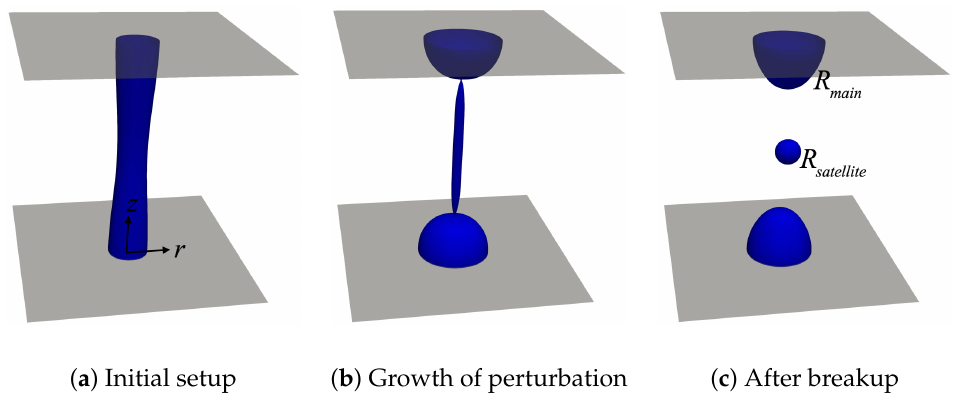
Figure 9. The evolution of the Rayleigh breakup of a liquid column leading to the final configuration consisting of a main droplet and a single satellite droplet. The top and bottom faces constitute periodic